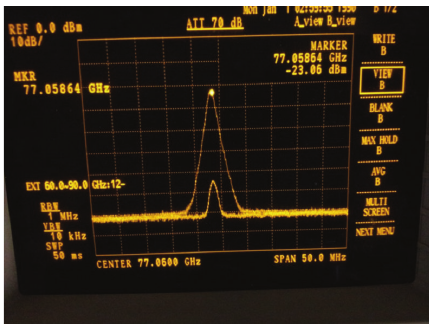
Figure 19: A screen shot of the spectrum analyzer showing both the transmitted and the received signal to verify the functionality of the Rotman